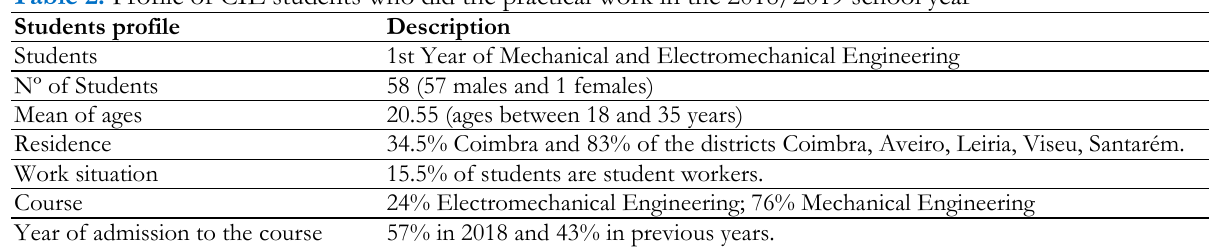
Table 2. Profile of CIE students who did the practical work in the 2018/2019 school year Students